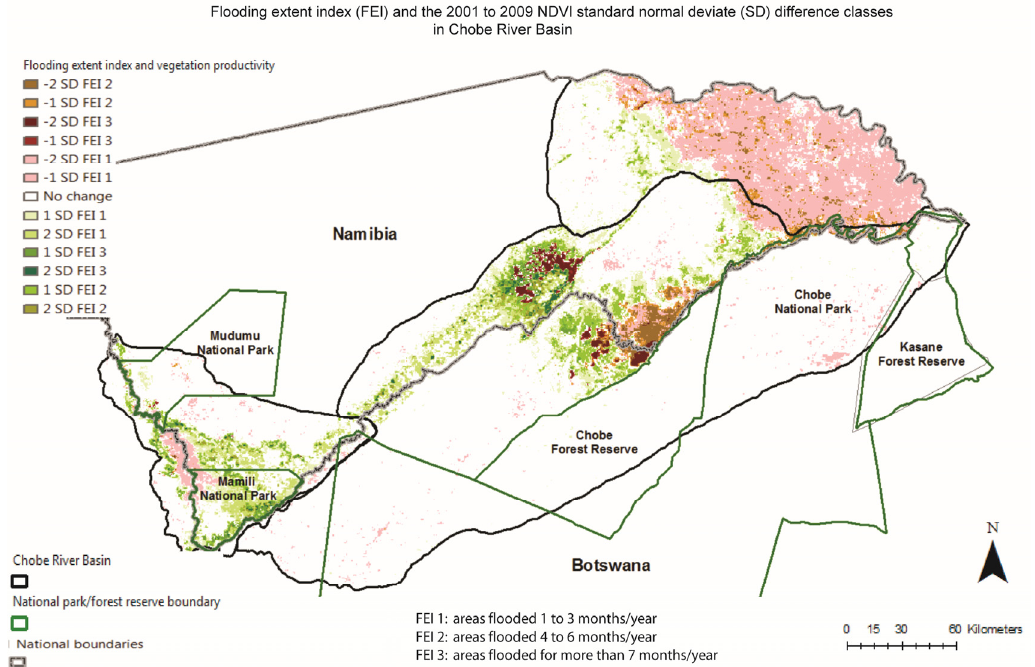
Figure 10. Spatial patterns of the coincidence between the 2001 to 2009 FEI (defined as the number of months an area was under inundation per year during the 2000 to 2009 interval) and the standardized 2001 to 2009 growing season NDVI image difference. Areas in green indicate increases in vegetation productivity in 2009 versus 2001, while areas in shades of red indicate lower vegetation productivities in 2009 as compared to